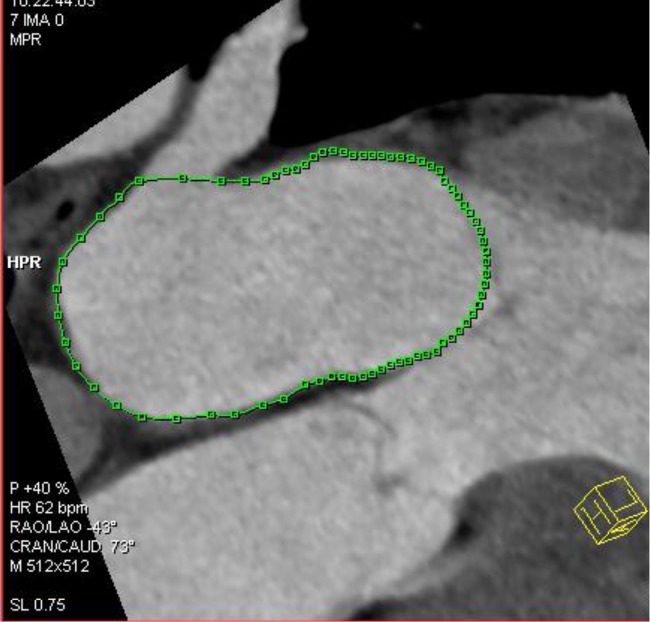
2D image of LA.Two-dimensional image illustrating how to delineate left atrial endocardium during postprocessing LA volume data.